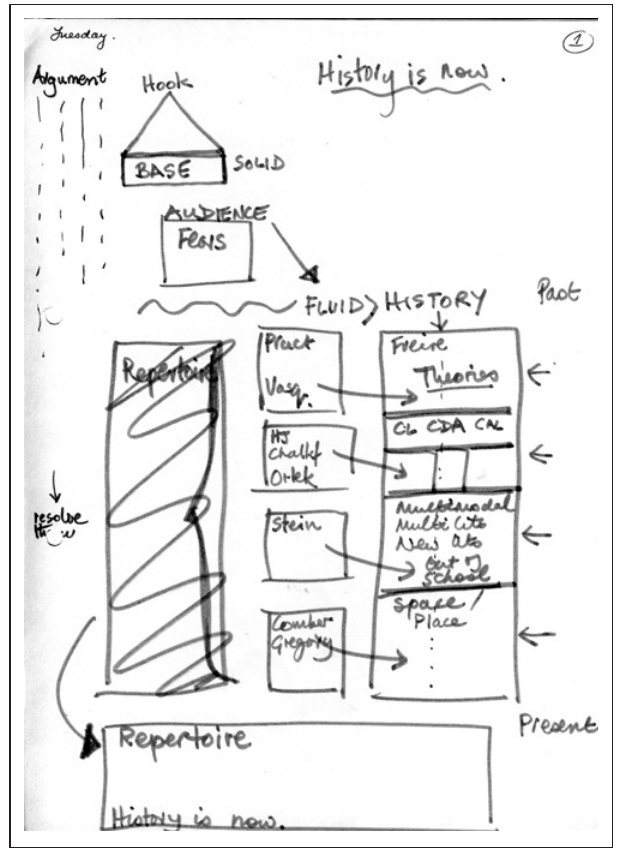
FIGURE 8: Rough work